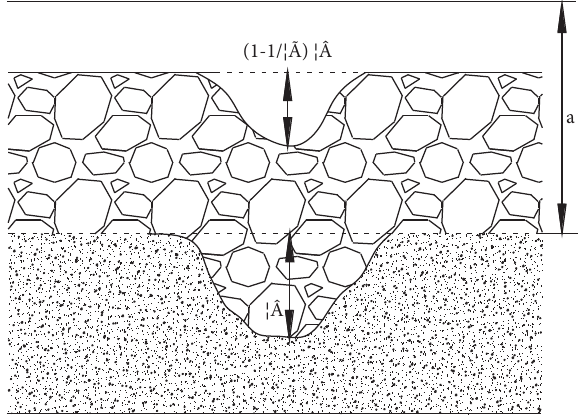
Figure 2: Schematic diagram of evenness